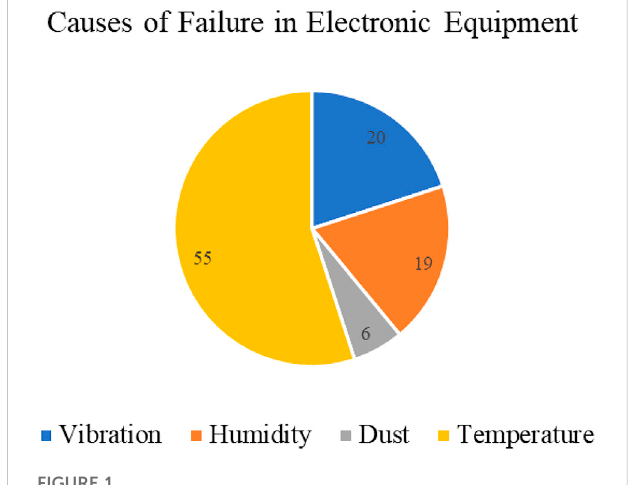
FIGURE 1 Causes of failure in electronic equipment (Khattak and Ali,